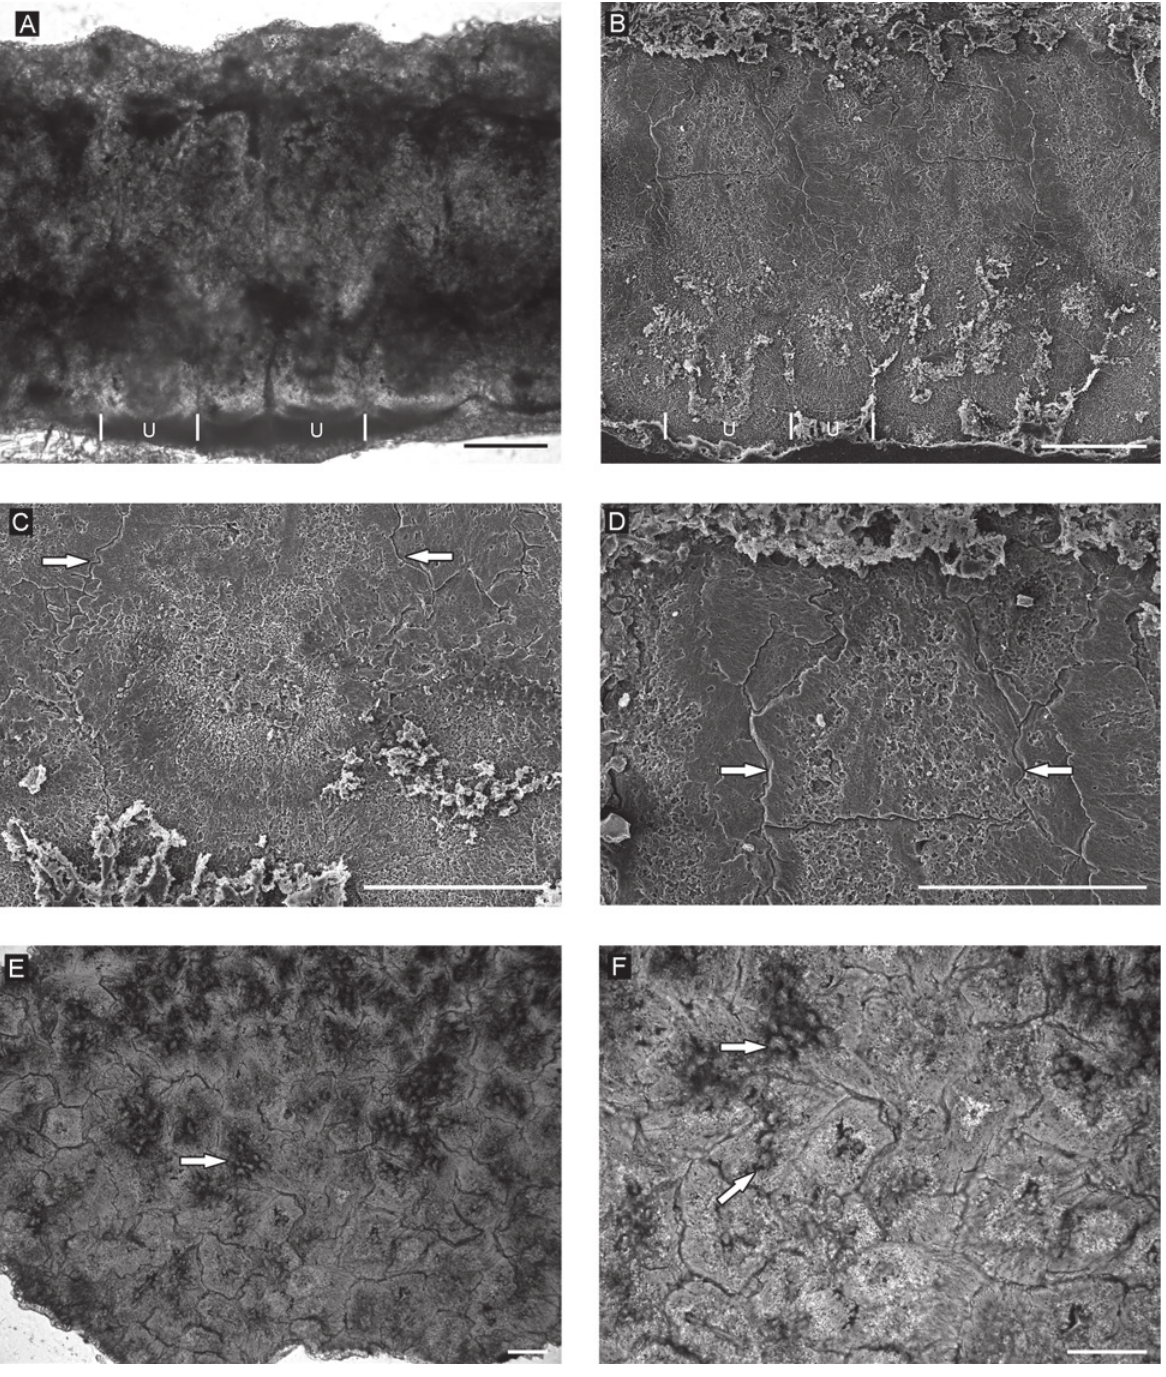
Fig. 4 - Eggshell microstructure of Emydoolithus laiyangensis oogen. et oosp. nov. A , radial section of eggshell (polarizing microscope); B - D , radial section of eggshell (SEM), C , enlarged lower part of the eggshell unit (SEM), showing aragonite ultrastructure, D , enlarged upper part of the eggshell unit (SEM), showing clear boundary of eggshell units; E - F , tangential section through the lower part of eggshell, E , showing tightly arranged eggshell units, F , enlarged part of E , showing crystal particles (white arrows) in eggshell units, Scale bars =100 μm, u: eggshell unit, the white arrows indicating the boundary of eggshell units in C and D